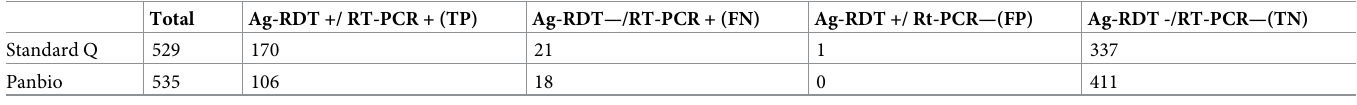
Table 3. RT-PCR and Ag-RDT